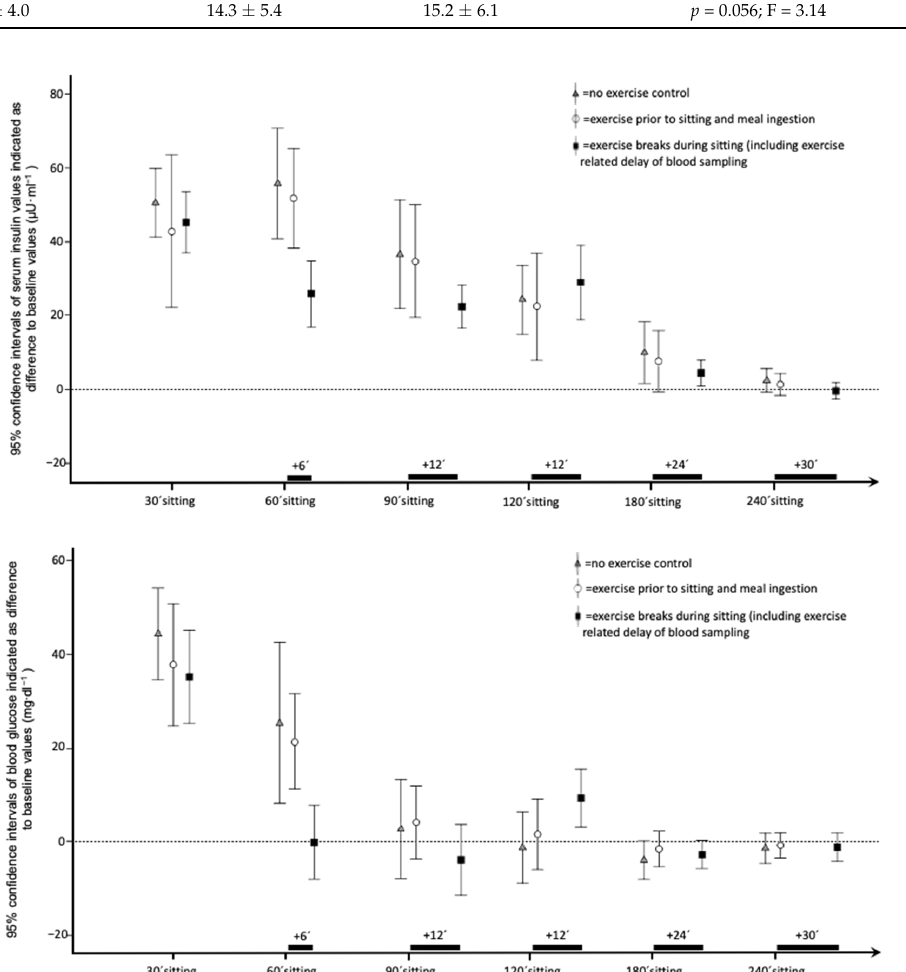
Figure 1. 95% confidence intervals of insulin and glucose blood values of all time points during interventions with 4 h of sitting and (1) no exercise, (2) 30 min exercise prior to sitting, or (3) 5 exercise breaks with matched overall duration (5 × 6 min). Insulin values are indicated as difference to individual baseline values in microunits pro milliliter ( μ U·mL − 1 ). Glucose values are indicated as difference to individual baseline values in milligrams per deciliter (mg·dL − 1 ). Timeframe in minutes starts with meal ingestion, and is indicated on the x -axis (’ = minutes). Dietary caloric intake was 2176 kJ ± 886, and in relation to bodyweight, 37 kJ/kg ± 15 (519.7 kcal ± 211.5; 8.9 kcal/kg ± 3.7). Participants ingested 66.06 g ± 26.89 glucose, 20.5 ± 8.34 fat, and 18.22 g ± 7.42 protein. The balance between ad libitum intake and exercise- related energy expenditure indicated that 58.4% ± 27.1 of the meal caloric content was burned during exercise. Based on CPET data, at 70% VO 2 max, the predominant energy source during physical activity was carbohydrate. Consequently, mean carbohydrate up- take during the ad libitum meal and expenditure during exercise was close to balance (+3.3 g ± 27.5). Table 2 indicates insulin and glucose baseline values and time series data, including maximal and minimal changes to baseline and incremental area under the curve, for each intervention. Baseline values showed no difference in fasting concentra- tions of insulin or glucose between trials. A priori Spearman correlation analysis indicated an association of dietary caloric intake with incremental area under the curve of insulin (exercise breaks: r = 0.787; exercise prior: r = 0.823; control: r = 0.822; p < 0.01) and glucose